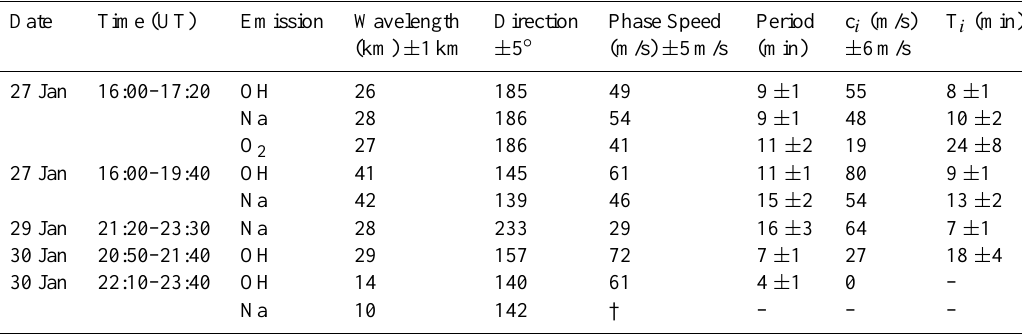
Fig. 5. Contour plot of the zonal and meridional winds measured by the Esrange meteor radar from 24 January to 1 February. A strong semi-diurnal tide was present during the campaign.